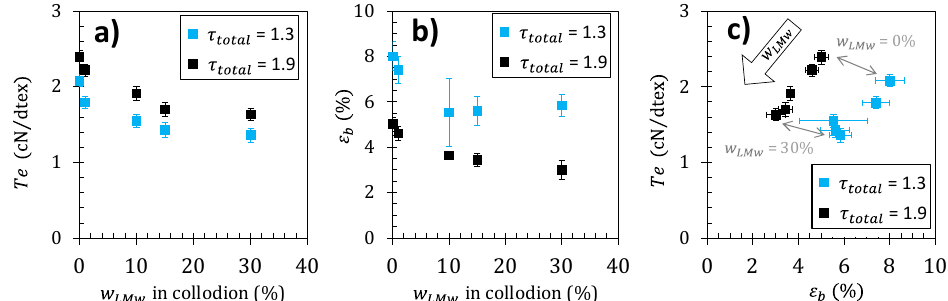
Figure 8. ( a ) Fiber tenacity-at-break ( T e ) and ( b ) strain-at-break ε b vs. LMW chitosan content w LMW , at the stretching rates total of 1.3 and 1.9. ( c ) Rupture plot for different LMW chitosan contents w LMW and stretching ratios. The arrow in represents the mechanical property trend associated with a w LMW increase.